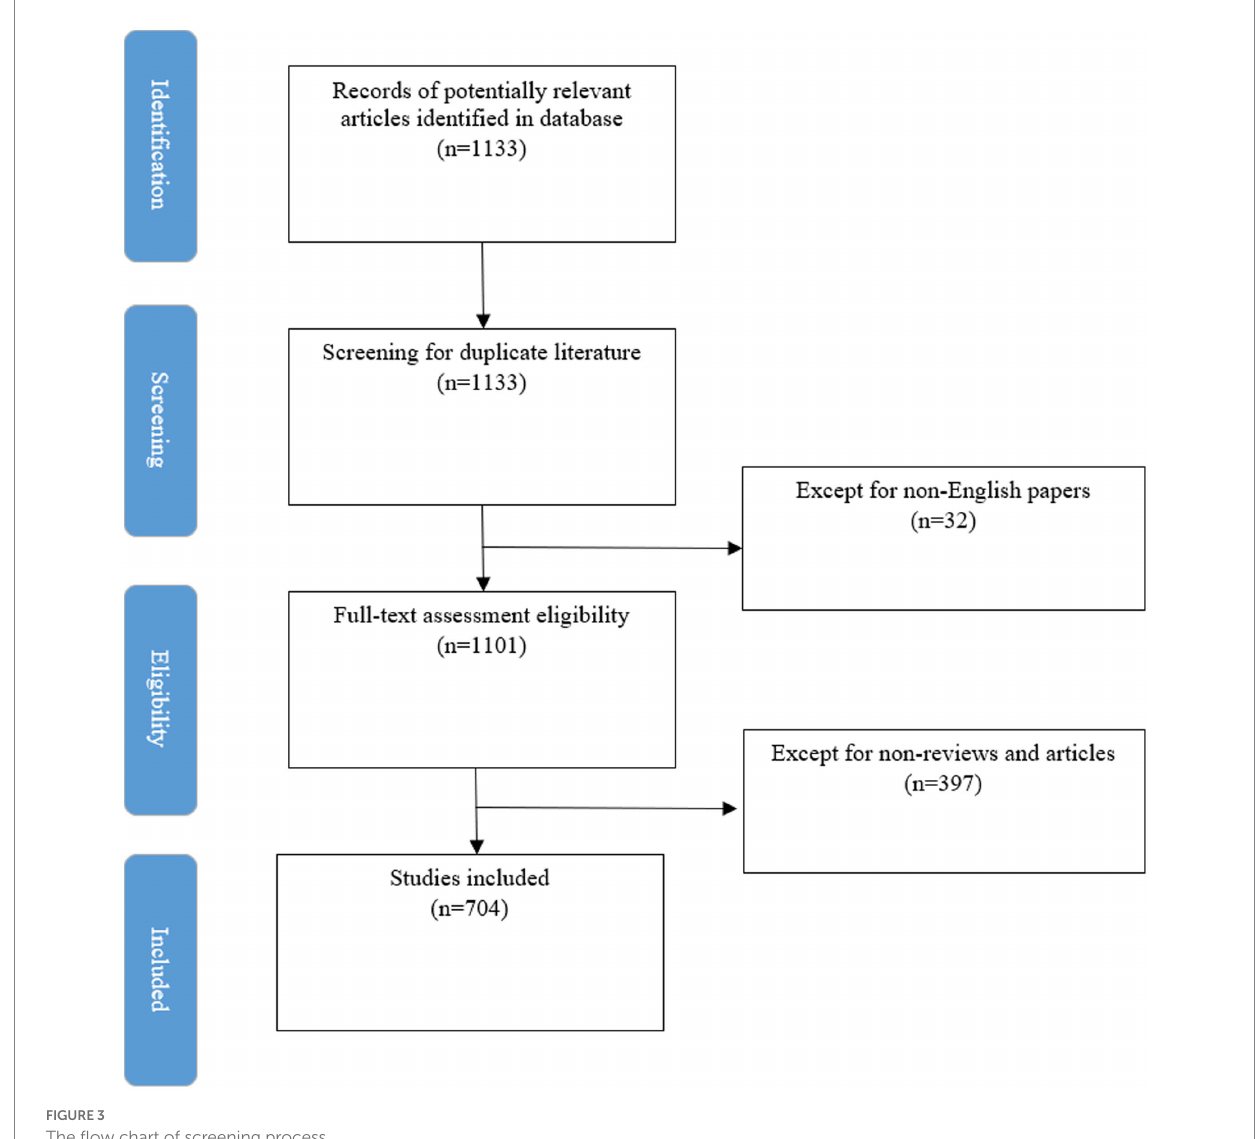
FIGURE 3 The flow chart of screening process.